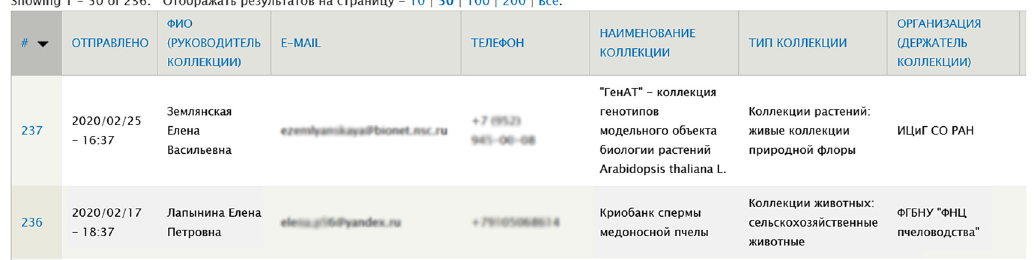
Figure 4: The summarylist of all applications forregistration of the collection, with which the editorial groupof the projectoffice then works. The list consists of the set of fields - date and time of the application, head of the collection full name, email, phone number, name and type of the collection, organization holding the